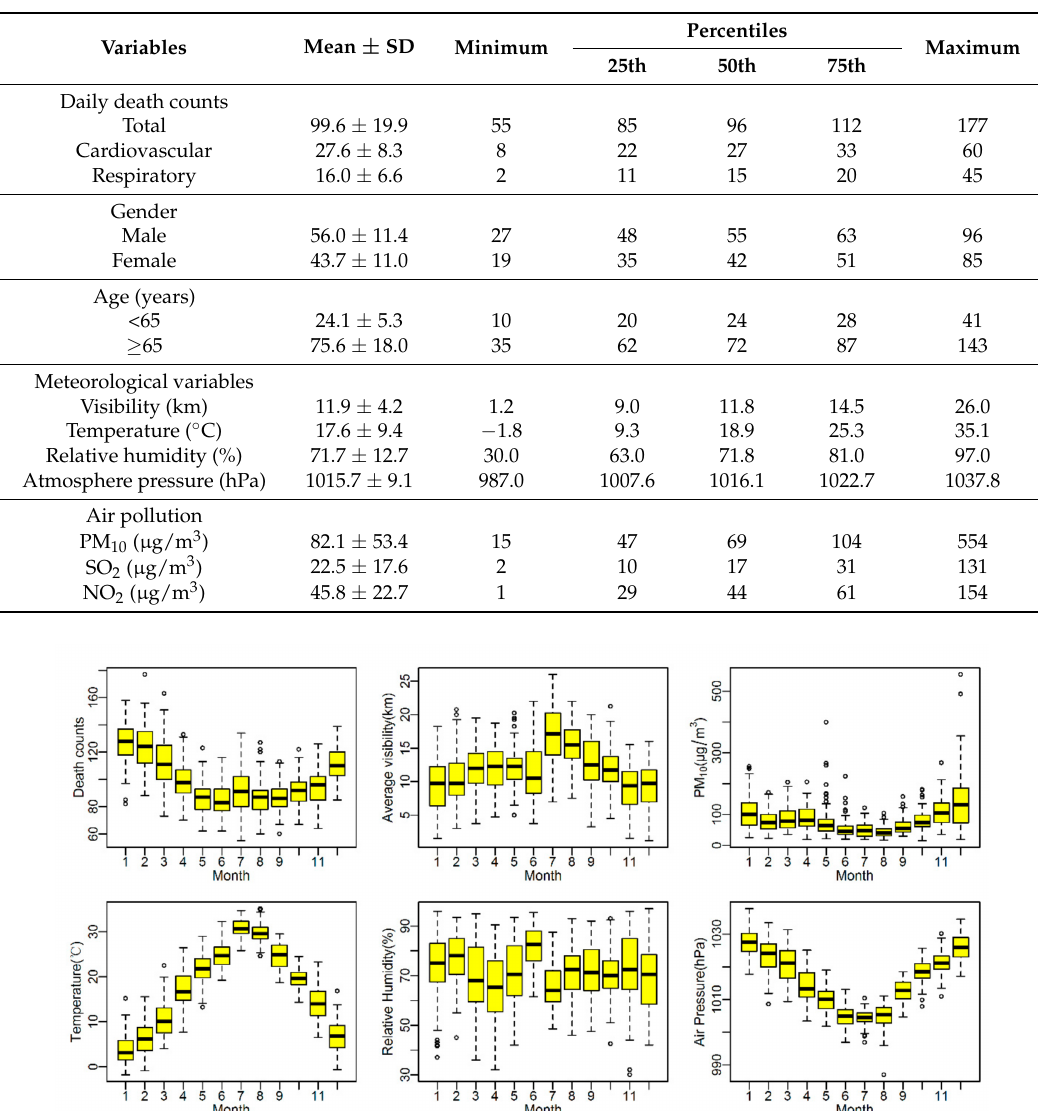
Table 1. Summary statistics for daily death counts, meteorological factors and air pollution in Ningbo city, during 2011–2013.